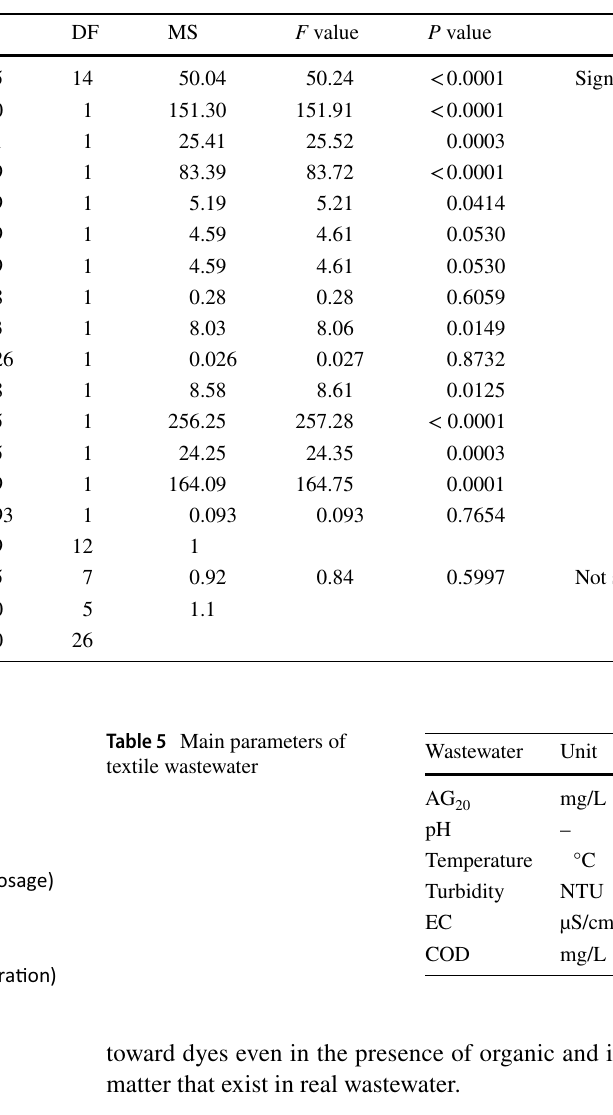
Fig. 3 Contribution percentage of parameters in removal